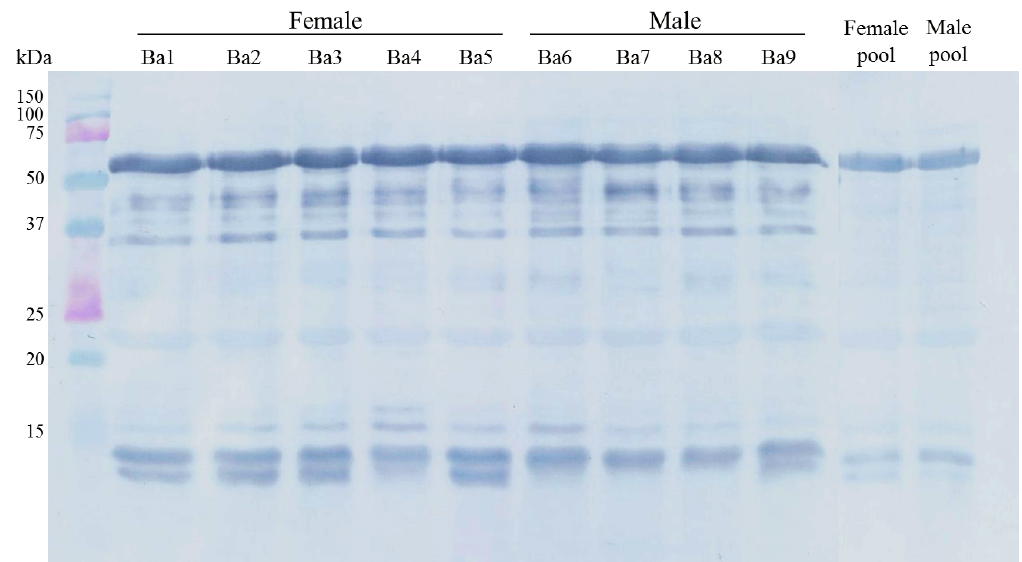
Figure 4. Immune interaction between the proteins of B. atrox venoms and the antibothropic serum by western blotting. Individual female (Ba1 to Ba5), male (Ba6 to Ba9) and respective pools were used and are indicated above the gel.